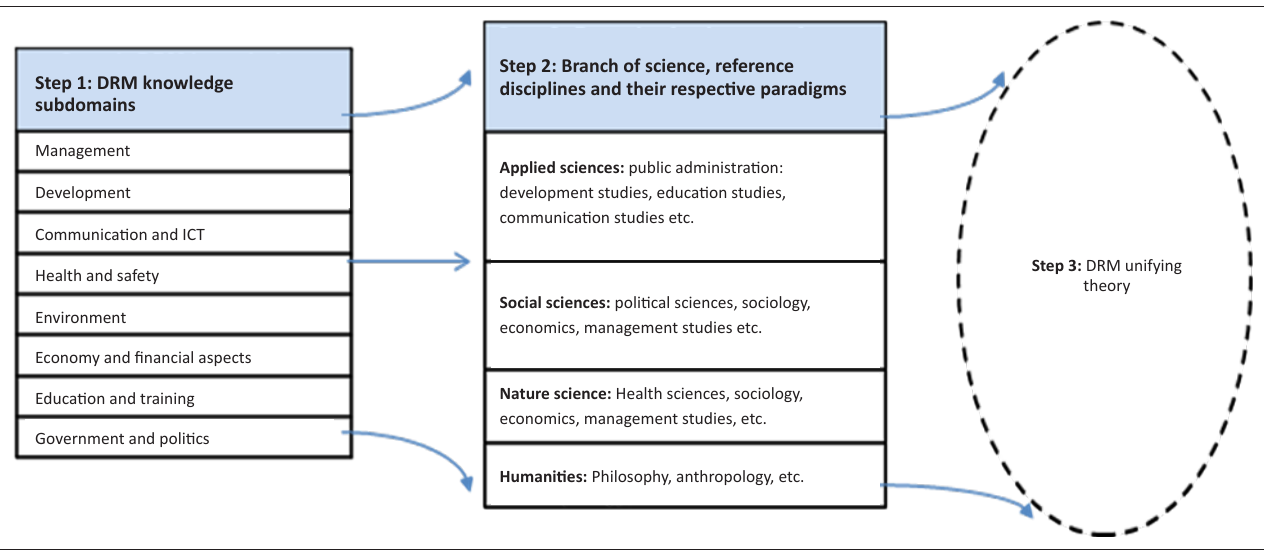
FIGURE 3: Steps towards a unifying theory for